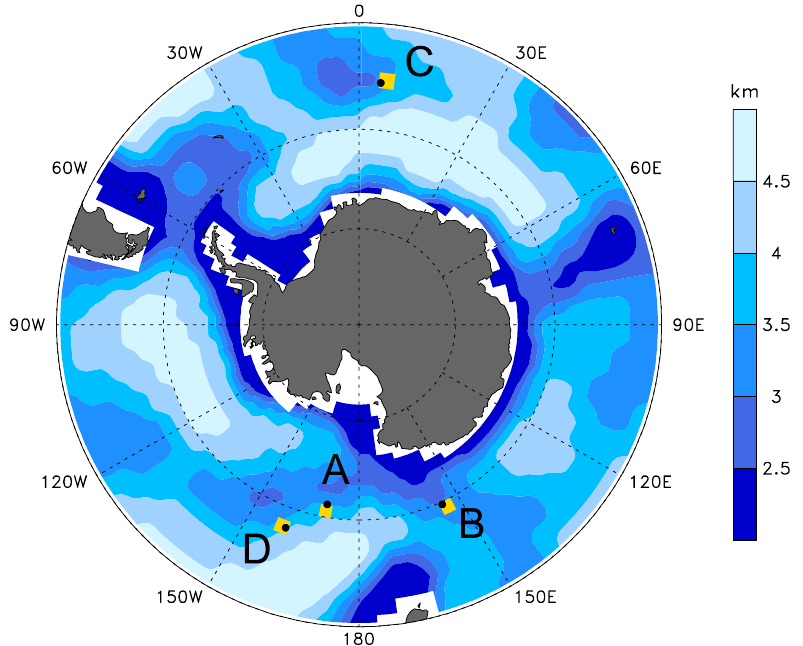
Figure 2. Southern Ocean topography denoted by the depth from ocean surface (shading) and the sites of four proxy cores: A. NBP9802-6PC (169.9 ◦ W, 61.9 ◦ S), B. E27-23 (155.24 ◦ E, 59.62 ◦ S), C. TN057-13-4PC (5.1 ◦ E, 53.2 ◦ S) and D. E14-6 (160.15 ◦ E, 57.01 ◦ S), which are denoted by black dots. The corresponding grids in TraCE-21ka are shaded in